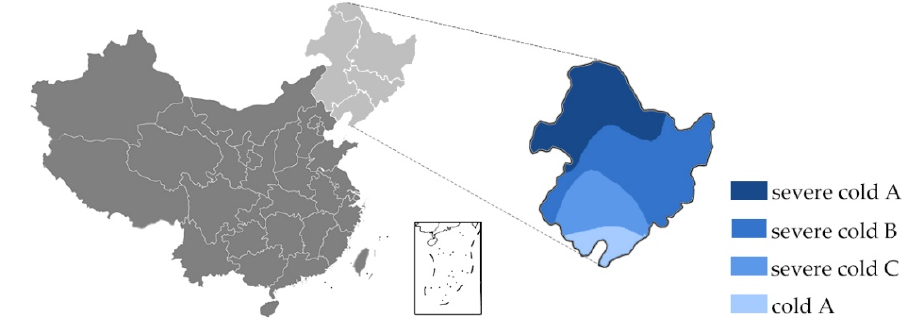
Figure 1. Climatic regionalisation of Northeast China (redrawn from [5]).